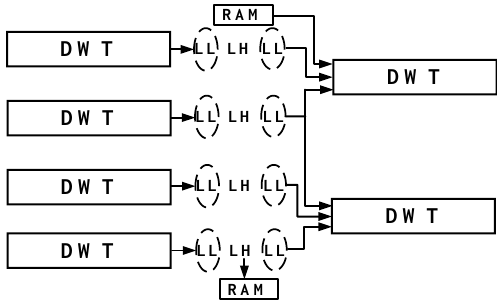
Figure 3. Structure of the lower level and the above level with a 2:1 parallelism ratio.